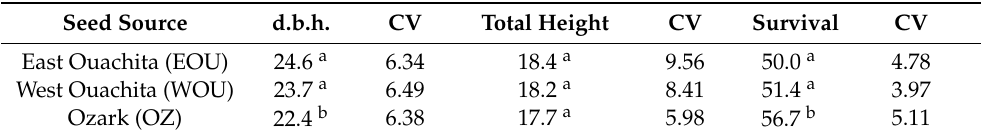
CV = Coefficient of variation (%). a,b Average